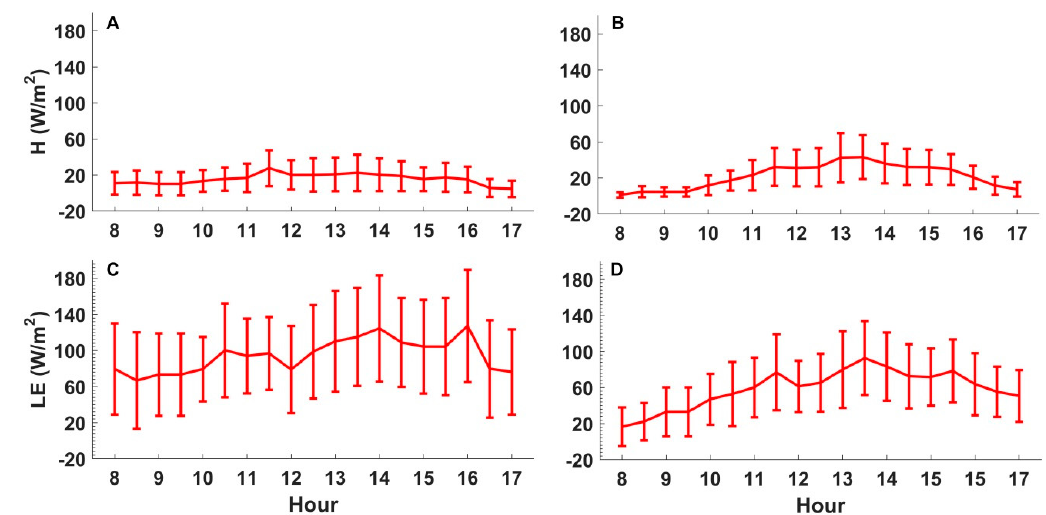
Figure 5. Diurnal variations in H and LE in 2015. ( A ) and ( C ) indicate the high-water period, and ( B ) and ( D ) indicate the low-water period. The length of the bar in each subfigure represents the value of the standard deviation of the energy fluxes.